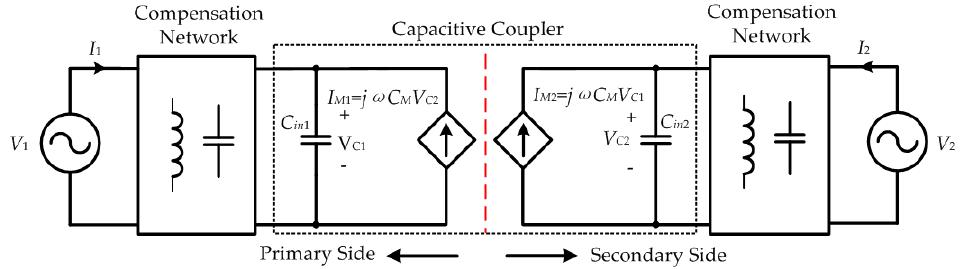
Figure 4. Simplified circuit topology of a CPT system.